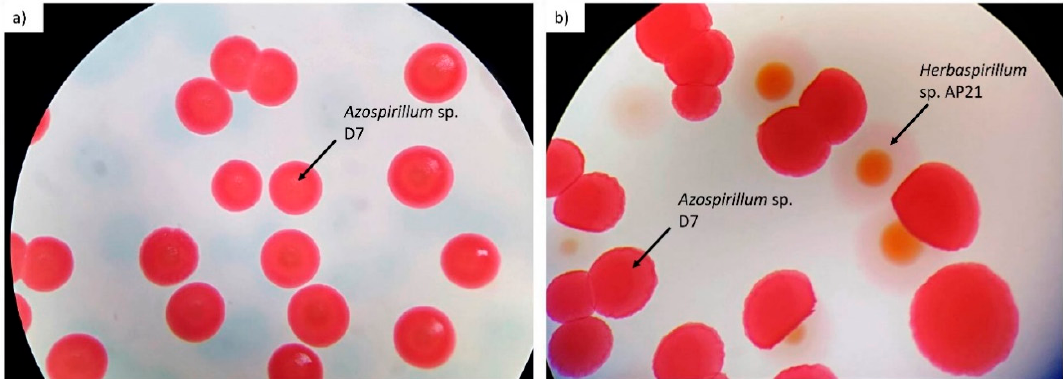
Figure 3. Colonies observed in the Herbaspirillum sp. AP21 and Azospirillum sp. D7 co-inoculations for the ( a ) indolic compounds and ( b ) exopolysaccharide determinations in congo red medium after 48 h of incubation at 30 ◦ C. The colonies were observed in a stereoscopic microscope (Olympus, SZX7, Shinjuku, Japan) with a 0.8× zoom. In the VOC assay, the inoculation of endophytic bacteria showed no significant effect on seed ger- mination; however, the radicle length significantly increased ( p < 0.05) with the individual inocula- tion and co-inoculation of most strains. Compared with the uninoculated control, the individual inoculation of P. fluorescens N7 and inoculation of Herbaspirillum sp. AP02 and Herbaspirillum sp.